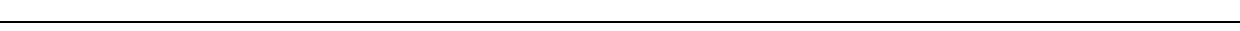
Fig. 1 Integrative gene addiction identi fi cation and validation. Schematic representation of bioinformatics based “ Target ID ” and functional validation RNAi experiment. a Composition of the Guy ’ s TNBC-enriched cohort of breast cancers, used as a source of DNA and RNA for this study. Two complementary approaches for candidate gene addiction identi fi cation. In green, copy number-dependent gene expression analysis shows initial fi lter for copy number gain/ampli fi cation and correlation to gene expression and subsequent Target ID algorithm. This pipeline consisted of a weighted scoring system for all genes based on copy number (CN), gene expression (GEX), gene, and clinical annotation listed here and in the Methods section. In purple, gene expression-centered analysis followed by manual curation based on gene annotation and literature evidence of an involvement in malignancy. b Work fl ow and hit selection criteria from primary functional validation RNAi experiment. *Top 10 genes were subject to different criteria as outlined in Results and Methods. c Example functional validation for TTK, using pool of four siRNAs across panel of cell lines. Mean normalized percent inhibition (NPI) from three independent experiments is plotted and error bars represent the standard error of the mean (SEM), n = 3. d Example of data from primary functional validation carried out in CAL51 cells. Data points represent the mean NPI from three independent replicates. Dashed line represents cut-off for positive hits at 18.01% NPI. e Mean NPI from CAL51 cell line after deconvolution of pool of TTK siRNAs used independently. Error bars represent SEM, n = 3. f mRNA knockdown of individual siRNAs in CAL51 cells. Knockdown was evaluated by qPCR and represented as mean percentage of knockdown compared to non- silencing control. Error bars represent SEM, n =